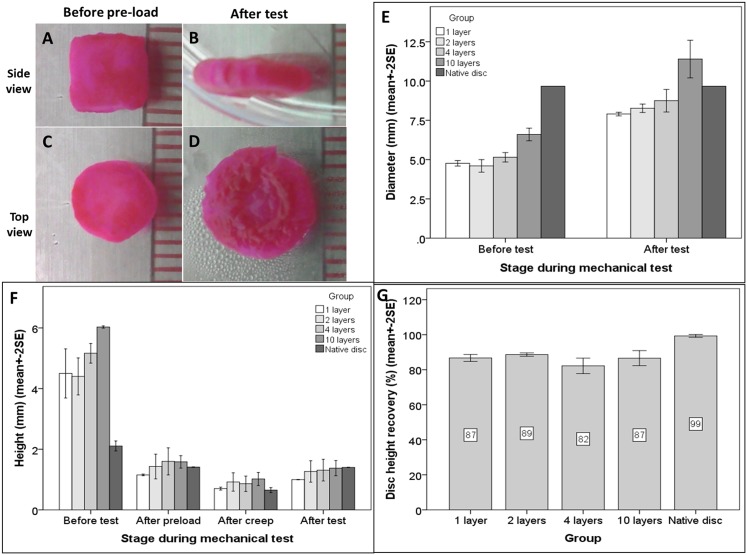
Gross appearance and dimension analysis of the samples in the different groups before and after biomechanical testing.(A-D) Gross appearance of the biphasic scaffolds from side (A-B) and top (C-D) views before (A,C) and after (B,D) the mechanical tests. (E-G) Dimension analysis of the biphasic scaffolds (with 1, 2, 4 and 10 layers of collagen lamellae) and the native disc controls at different stages during the mechanical test (i.e., before and after pre-load, after the creep, and after the test). Bar graphs show: (E) disc diameter, (F) disc height, and (G) percentage of disc height recovery. Data are expressed as mean+-2SE of n = 2–4 experiments.